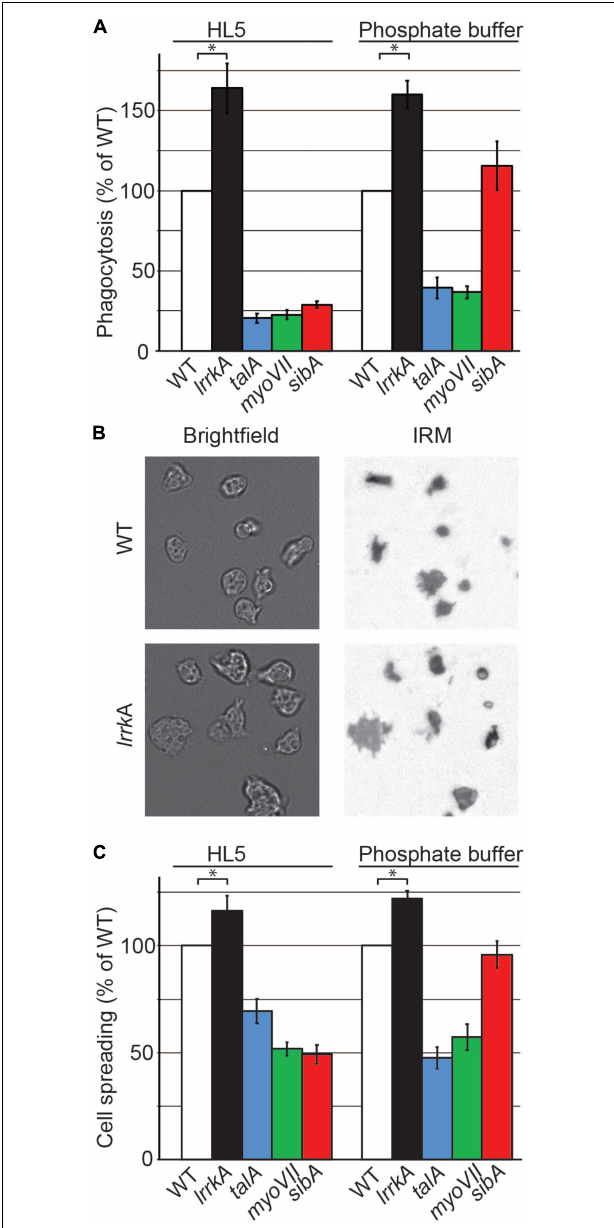
FIGURE 5 | Genetic inactivation of lrrkA increases interaction with substrates in HL5 and in phosphate buffer. (A) Phagocytosis of polystyrene beads was measured for the indicated mutant cells as described in the legend to Figure 1 . LrrkA KO cells phagocytosed more efficiently than WT cells both in HL5 and in phosphate buffer (PB) (average ± SEM; ∗ p < 0.01, Mann–Whitney test; N = 19 independent experiments). (B) Brightfield and interference reflection pictures of WT and lrrkA KO cells (here in HL5) allow to visualize the contact area between cells and their substratum. (C) Spreading of WT and mutant cells on their substrate in HL5 and in PB reflects their ability to phagocytose particles. The contact surface between WT cells and the glass substrate was 62 and 87 µ m 2 in HL5 and SB, respectively. Spreading of all mutants analyzed was significantly different from WT, except for sibA KO cells in phosphate buffer (average ± SEM; ∗ p < 0.01, Student’s t -test, number of cells analyzed in HL5/SB: WT 197/162; lrrkA 199/85; talA 173/125; myoVII 242/79; sibA 202/121; N = 2 independent